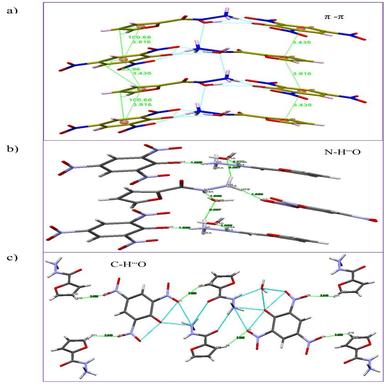
ystal packing a) π-π b) N-H...O and C-H...O interactions